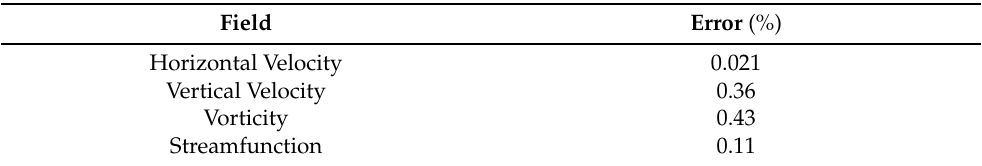
Table 1. The 2-norm relative error of numerical solutions compared to the analytical solutions for the Poiseuille Symmetric Plannar